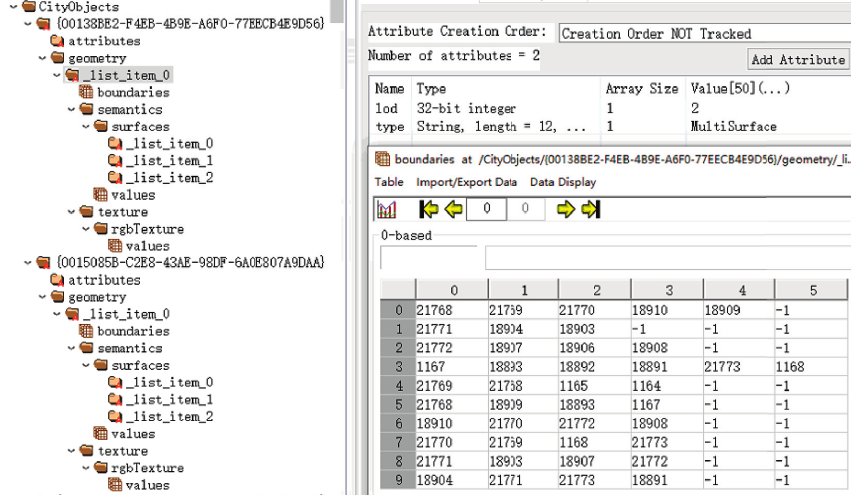
Figure 22: A demonstration of almost all details of the transformed CityJSON in